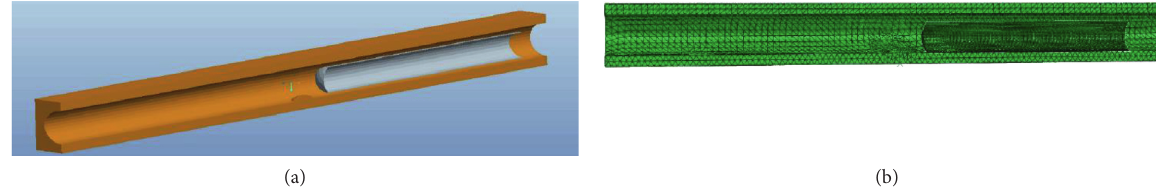
Figure 3: Simplified model and meshing diagram of stepped hole crossing.